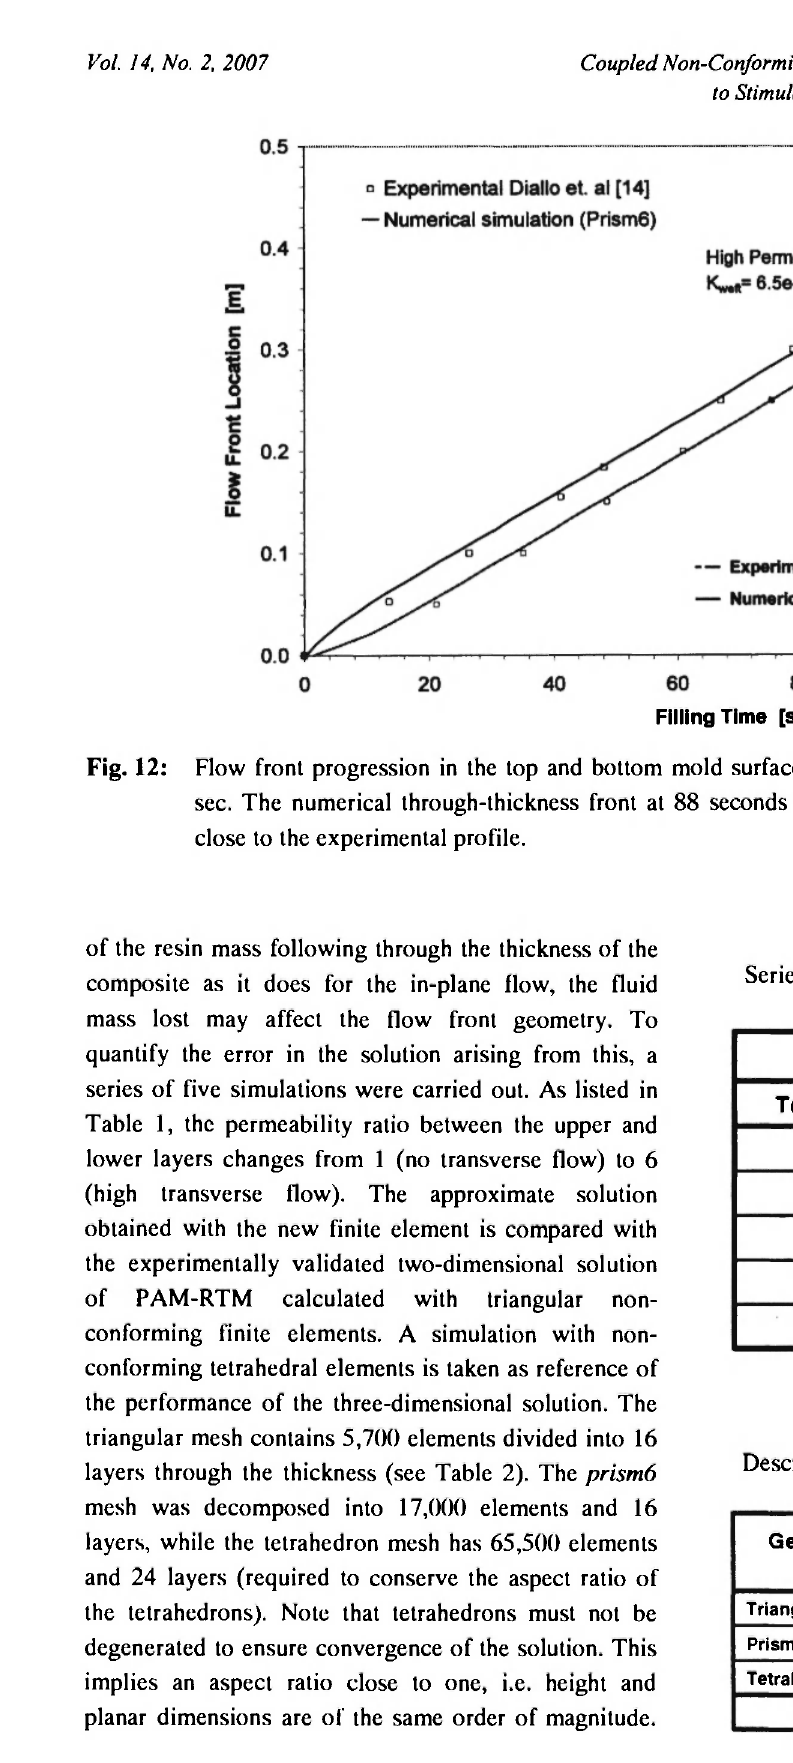
Description of the 2D and 3D meshes used to compare the error on the mass